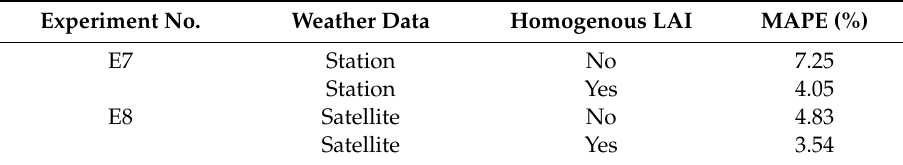
Table 4. Performance validation of SIMRIW–RS for 2019 crop data.